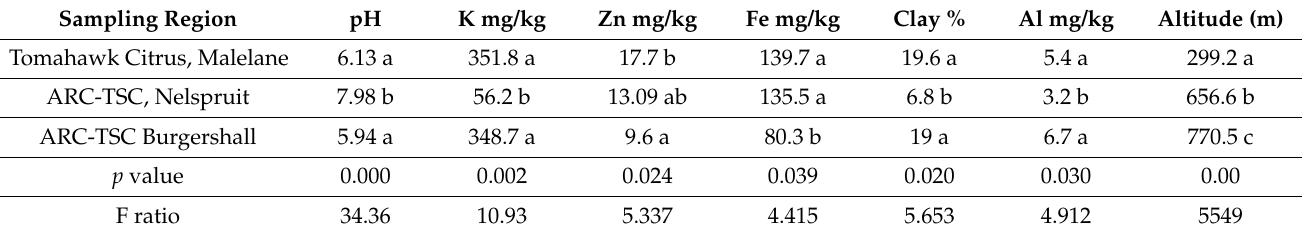
Table 2. Selected soil physical parameters as well as the altitude that differed significantly among the three geographic regions sampled. Different letters indicate significant differences for each parameter at p ≤ 0.05 based on Tukey’s test.